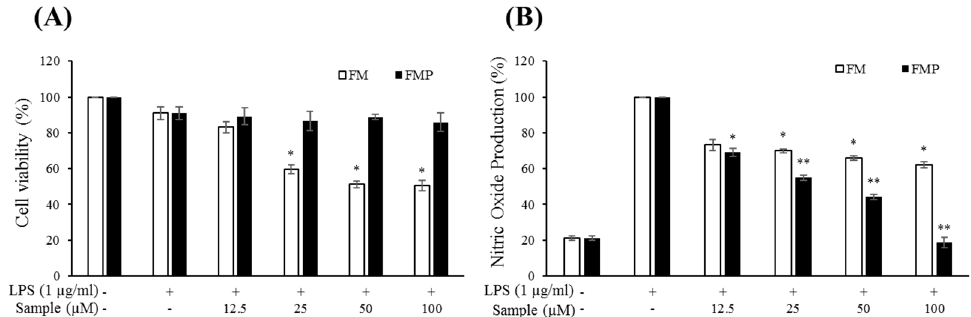
Figure 2. E ff ects on cell viability and nitric oxide production by FM and FMP in lipopolysaccharide (LPS)-stimulated RAW 264.7 cells. ( A ) Cell viability was assessed in cells stimulated with LPS (1 µ g / mL) in the presence of FM or FMP for 24 h; ( B ) nitric oxide production was determined using the Griess reagent method. The data represent the mean ± SD of triplicate experiments. * p < 0.05, ** p < 0.01 versus LPS alone.